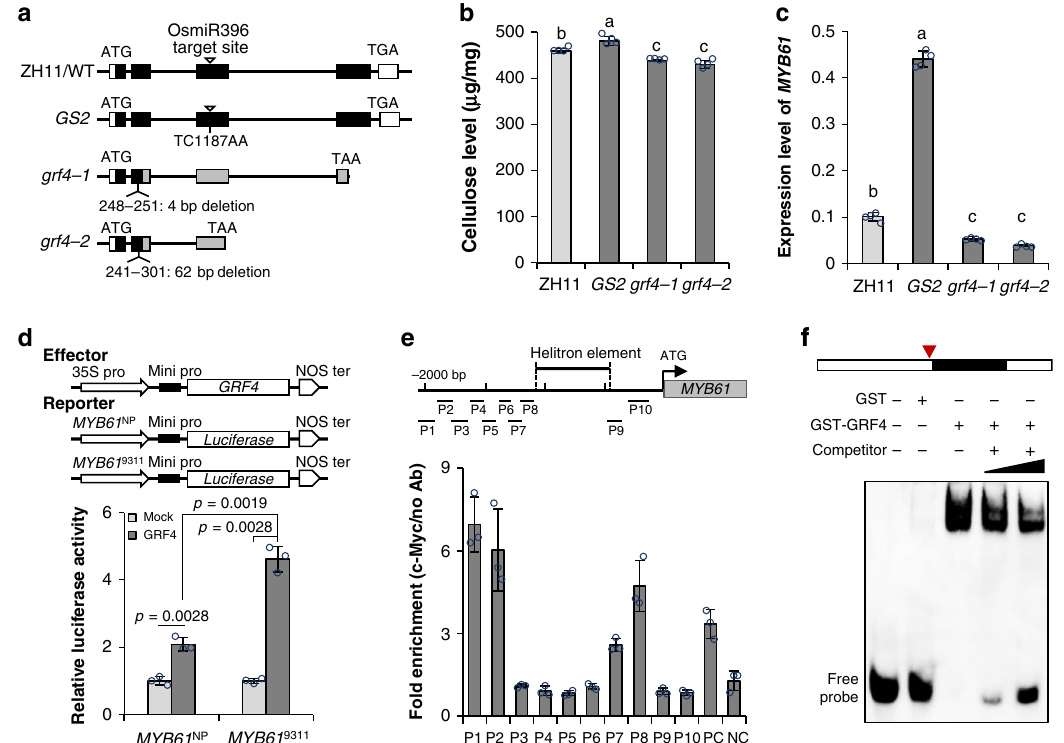
Fig. 4 GRF4 is involved in cellulose biogenesis via regulating MYB61 transcription. a Schema of GRF4 gene structure and the mutation sites of GS2 and grf4 mutants. Boxes and lines in the diagram indicate exons and introns, respectively. Gray boxes indicate mutated parts in the mutants. b The cellulose content, µ g in per mg of cell wall residues prepared from the internodes of the indicated plants. Error bars indicate the mean ± SD of four biological replicates. Letters a – c indicate the different means according to Duncan ’ s multiple range test ( p < 0.05). c The expression level of MYB61 in the leaf sheaths of indicated plants. Rice HNR was used for normalization. Error bars represent the mean ± SD of four biological replicates. Letters a – c indicate the different means according to Duncan ’ s multiple range test ( p < 0.05). d Transcriptional activation assays by cotransfecting Arabidopsis protoplasts with the constructs shown in the upper panel. The luciferase activity was normalized with that of the cells coexpressing the empty effector (Mock). Error bars represent the mean ± SD of three biological replicates. Statistical signi fi cance was calculated with two-tailed Welch ’ s unpaired t -test and p values are indicated. e ChIP-PCR enrichment of the GRF4-cMyc targeting DNA fragments in the MYB61 promoter region. The upper panel indicates the locations of the DNA fragments subjected to ChIP-PCR analysis. Error bars represent the mean ± SD of three biological replicates. Rice glutamine synthase GS1.2 was used as the positive control (PC); an exon of MYB61 was used as the negative control (NC). f EMSA assay, showing the GRF4 recombinant proteins bound to the motif neighboring to the helitron element insertion site at the MYB61 promoter region. The open and black boxes indicate the MYB61 promoter and the helitron element, respectively. The red triangle indicates the site for generating the probe. n = 3 independent experiments. Source data underlying Fig. 4b – f are provided as a Source Data fi